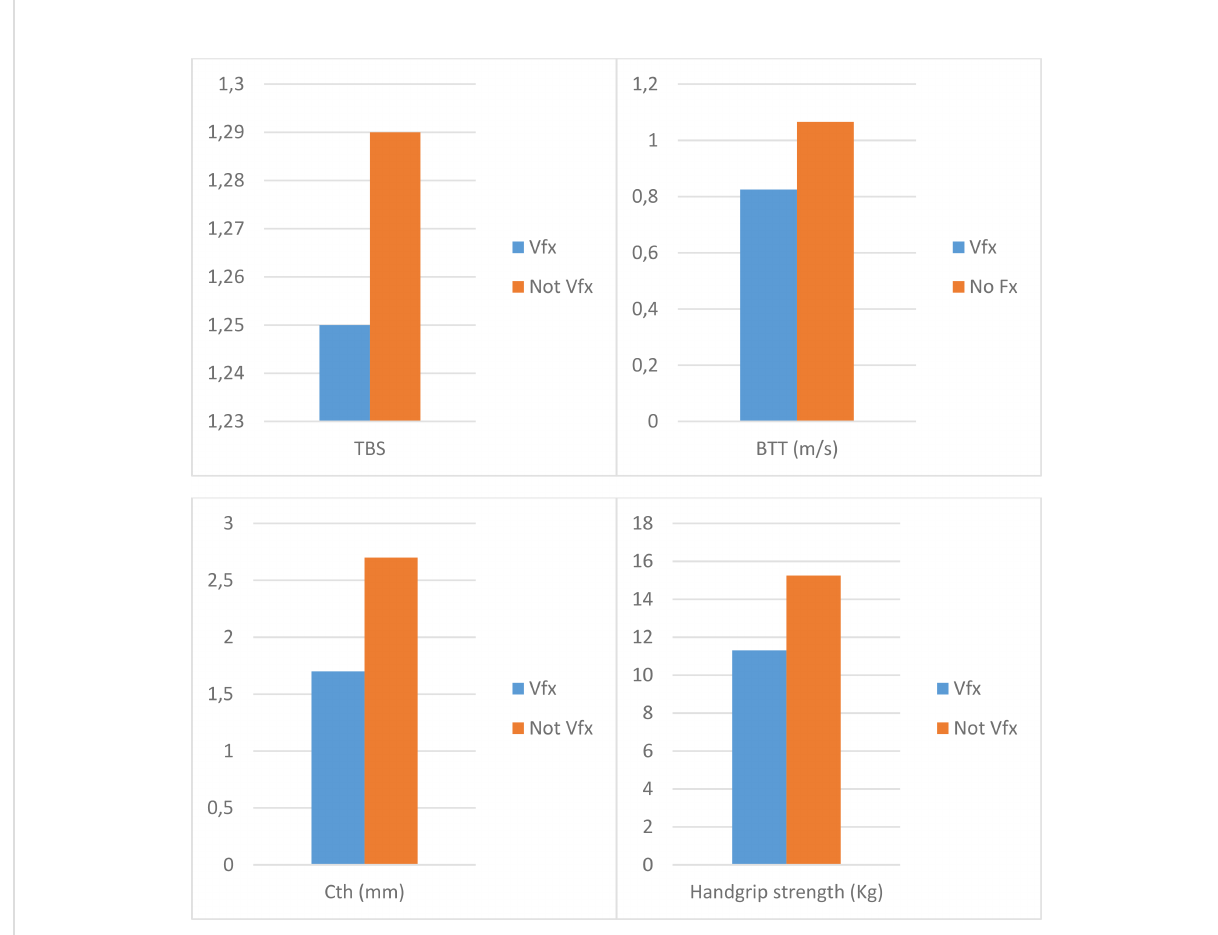
FIGURE 1 Differences in the trabecular bone score, bone transmission time, cortical thickness, and handgrip strength according to the presence of vertebral fractures in hemodialysis patients. Values are expressed as median and are signi fi cantly different between Vfx and not Vfx groups ( p < 0.05) for all the variables. TBS, trabecular bone score; BTT, bone transmission time; Cth, cortical thickness; Vfx, vertebral